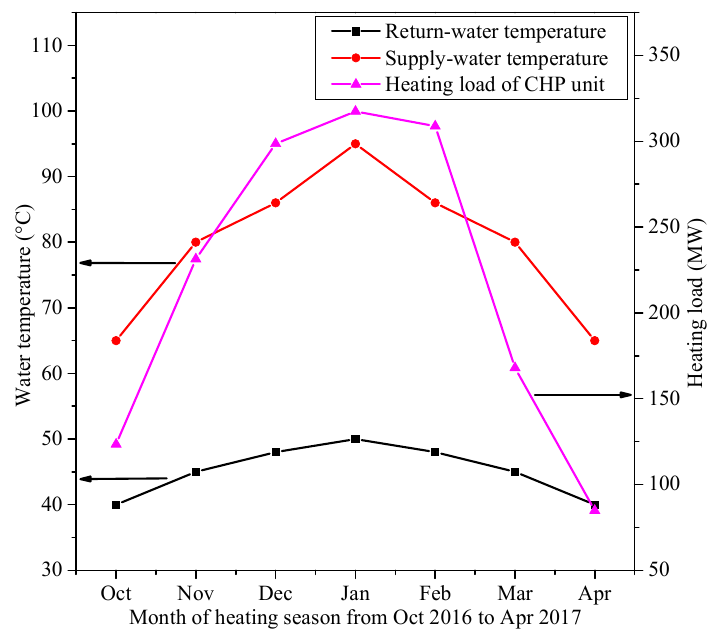
Figure 3. Average supply and return-water temperatures of the thermal network and heating load of the CHP unit in different months during the heating season from October 2016 to April 2017.